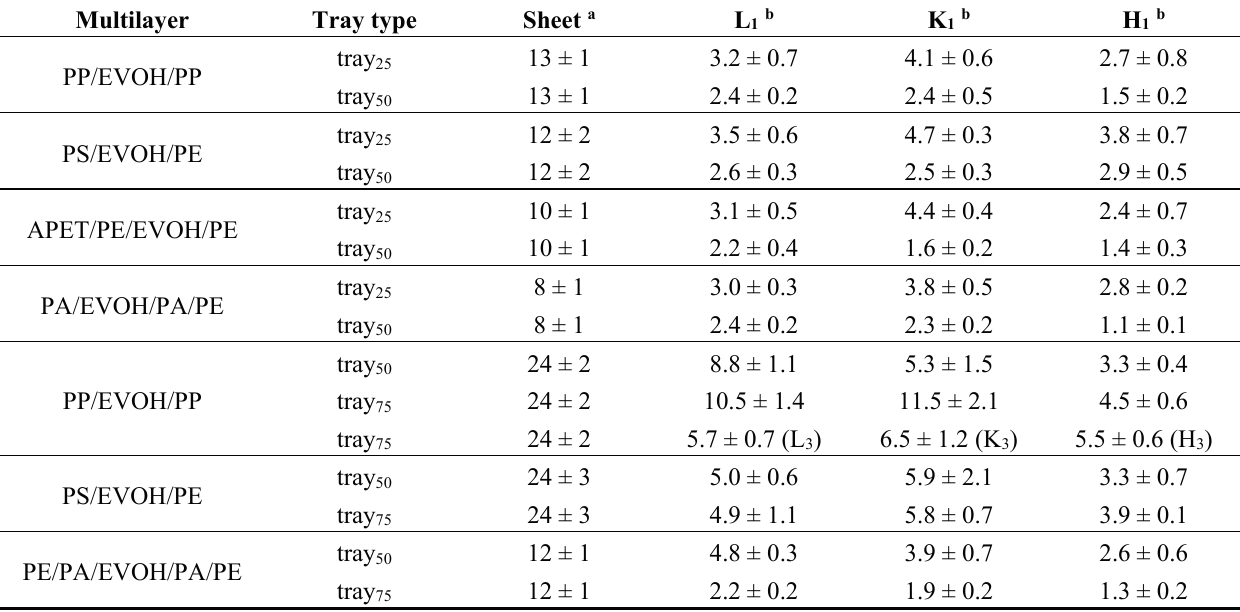
Table 6. EVOH layer thickness in the most critical locations of the tray versus sheet material in µm.